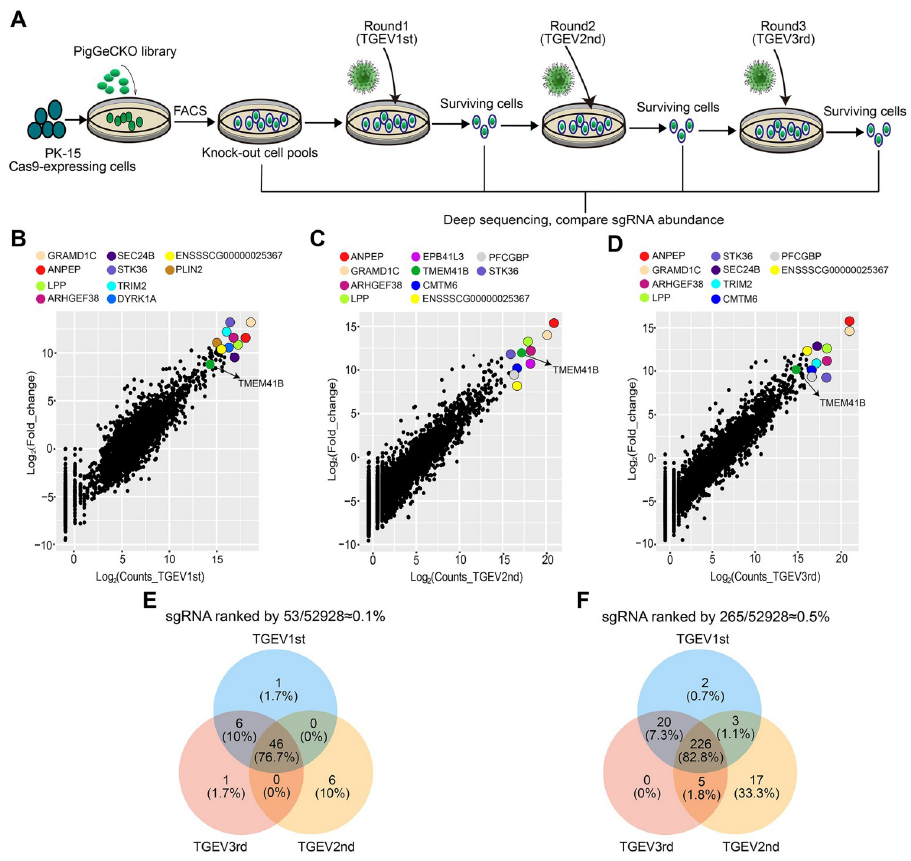
Fig 1. Genome-wide CRISPR screening to identify genes associated with alpha-CoVs TGEV-induced cell death. (A) Identification of TGEV host factors using the porcine genome-scale CRISPR/Cas9 knockout (PigGeCKO) library. Transformed PK-15-Cas9 cells were either mock-treated or challenged with TGEV (MOI = 0.001). Surviving cells from each round of virus challenge were isolated, with the subsequent PCR amplification and sequencing of sgRNA. (B-D) Scatter plots showing sgRNA-targeted sequence frequencies and the extent of enrichment in transformed PK- 15-Cas9 cells (mock-treated versus TGEV infected) in three rounds of TGEV screening; (B) first, (C) second and (D) third, respectively. Counts_TGEV1st/Counts_TGEV2nd and Counts_TGEV3rd are the average reads from the paired- end sequencing for each round. Log2(fold change) is the median log 2 ratio between normalized sgRNA count of TGEV challenged and mock-treated populations. (E and F) Venn diagrams indicate the scope of overlapping enrichment in specific sgRNA targeting sequences for the three TGEV screening rounds amongst the top (E) ~0.1% and (F) ~0.5% of averaged sgRNAs reads. FACS, Fluorescence Activated Cell Sorting; TGEV, Transmissible gastroenteritis virus; sgRNA, small guide